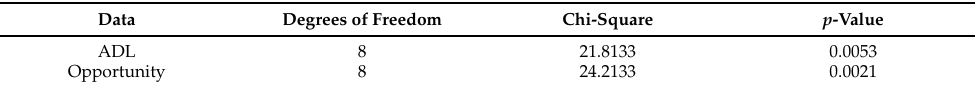
Table 10. Friedman test results indicate that the p -value is less than 0.05 ( α = 0.05) for the ADL and Opportunity datasets. This means that one or more of the sampling methods is more effective than the